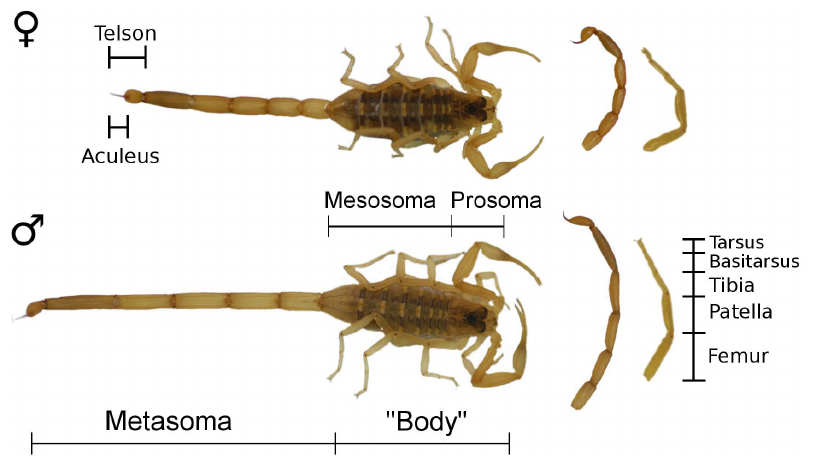
Figure 1. Morphology of representative male and female scorpions (Centruroides vittatus). Whole body, metasoma-alone, and leg-alone (right 4 th leg) images are presented on different scales, though relative sex differences are